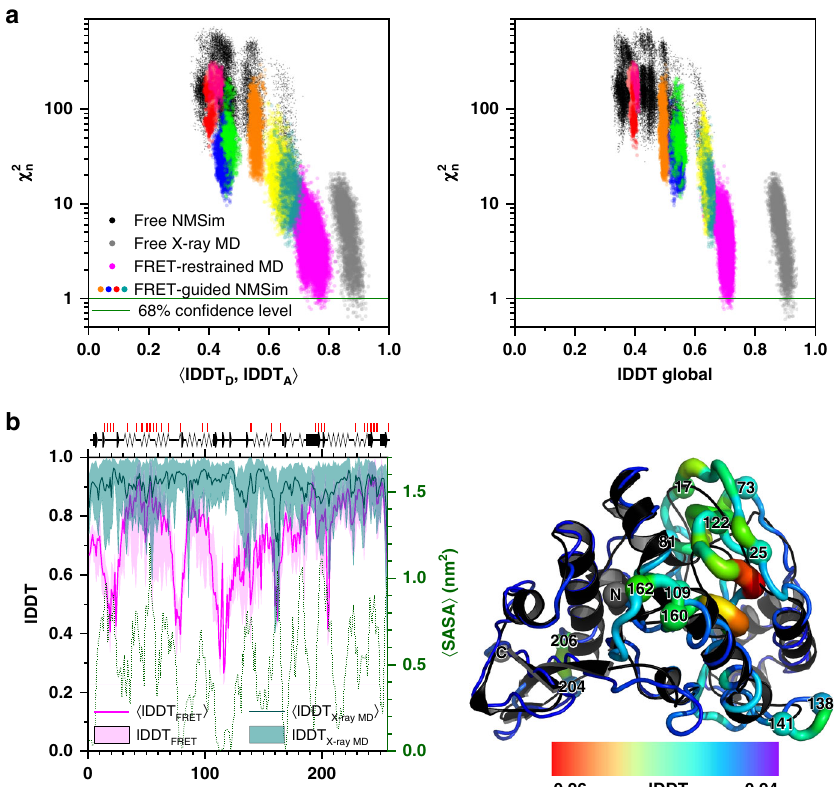
values and local n